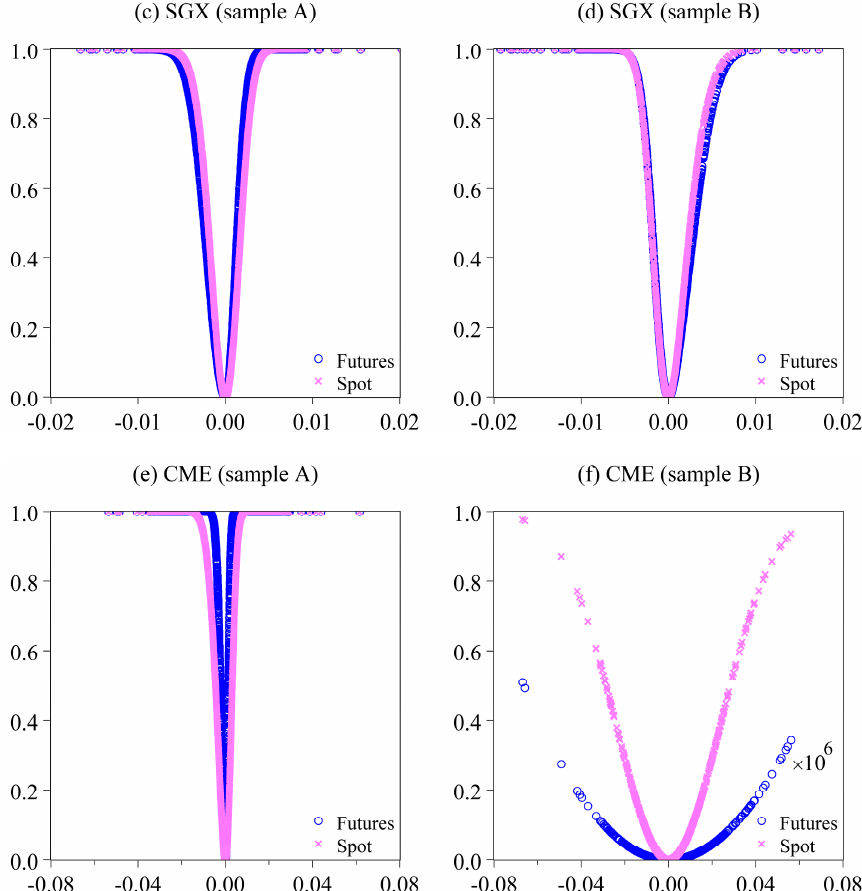
Figure A1. Spot–futures transition functions. Notes: ( a – f ) plot the Nikkei spot–futures transition functions estimated from Equations (8) and (9). T ( z t − d ) on the vertical axis is plotted against z t − d on the horizontal axis. For ( f ) only, since the spot γ is very large in value, the parameters are standardised by dividing γ ( θ ) by the sample variance (standard deviation) of z t − d ; the estimates of the futures transition function are multiplied by 10 6 .